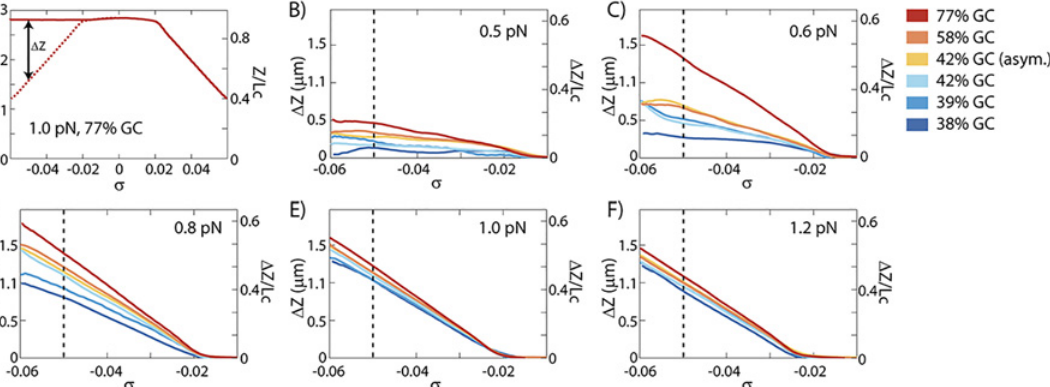
Fig 3. Length increase due to melting. The length increase due to melting, Δ Z is calculated from the extension at negative supercoiling density minus the extension at similar positive supercoiling density, Δ Z = h Z ( − | σ |) i − h Z (+| σ |) i . (A) Illustration of Δ Z with the data of the 77%GC construct at 1.0pN. (B-F) Δ Z as function of supercoiling density σ for forces between 0.5pN and 1.2pN. A positive Δ Z occurs when applied negative supercoiling induces melting where similar positive supercoiling induces plectonemes. At forces below 0.5pN, Δ Z is zero and no melting occurs. An increase in GC content results in a larger amount of melting and a smaller amount of plectoneme formation at the same force. The dotted lines at σ = -0.05 indicate the values of Δ Z used for Fig 4A in which the force dependence of Δ Z is shown. On the right axis the extension is presented relative to the contour length of the molecule (3.33 μ m). The difference in noise between positive and negative supercoiling ( Δ std ) are shown in S3